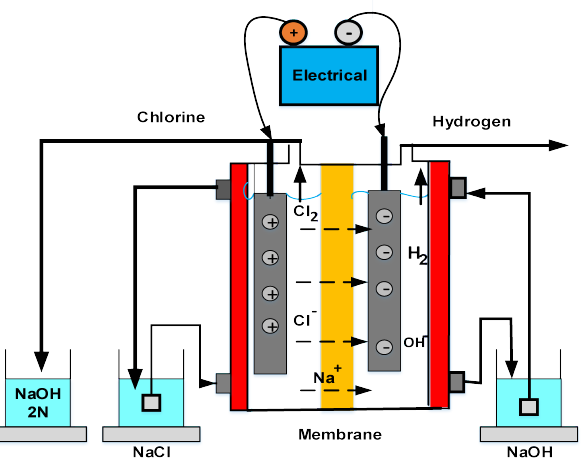
Figure 3. Membrane cell